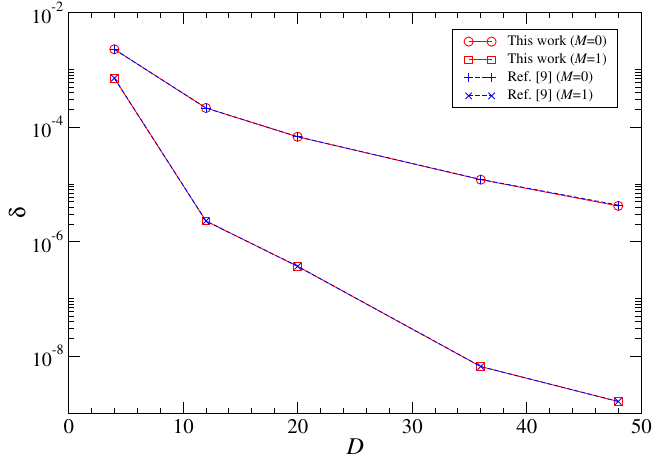
Figure 6 . Relative error for the free energy of Wilson fermions on 1024 × 1024 lattice as a function of D